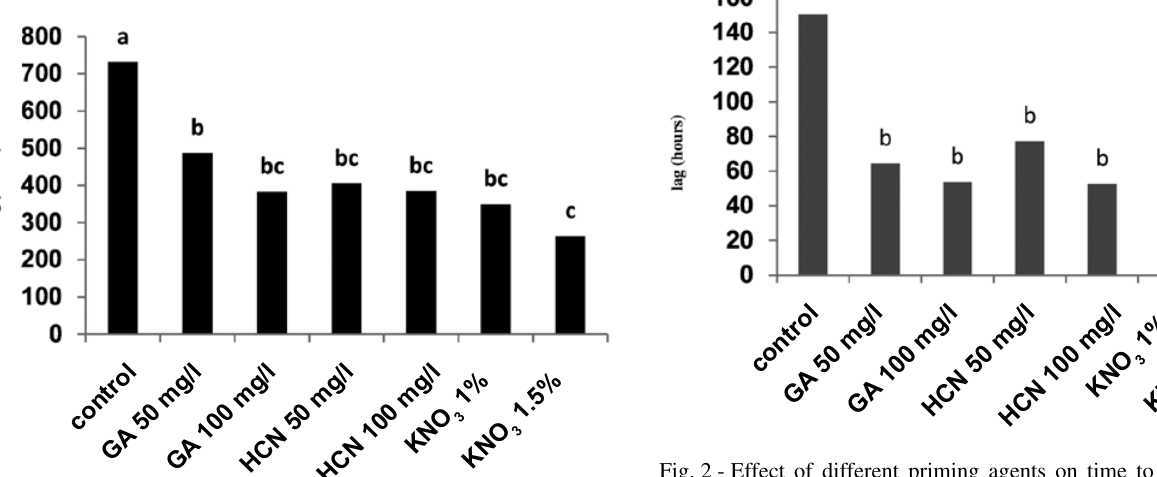
Fig. 2 - Effect of different priming agents on time to germination at onset (lag phase) of Shahpasand pistachio variety.